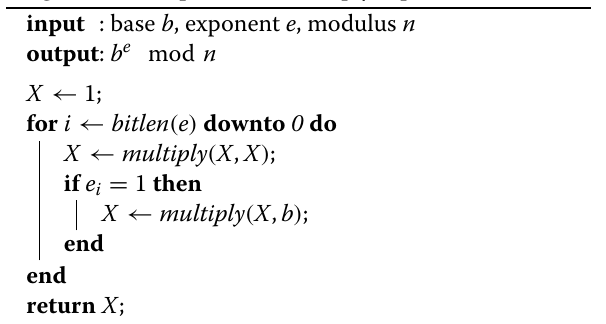
Algorithm 1. The algorithm sequentially scans over all